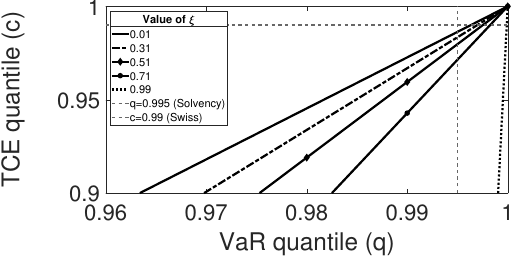
Figure 1. TCE quantile as a function of VaR